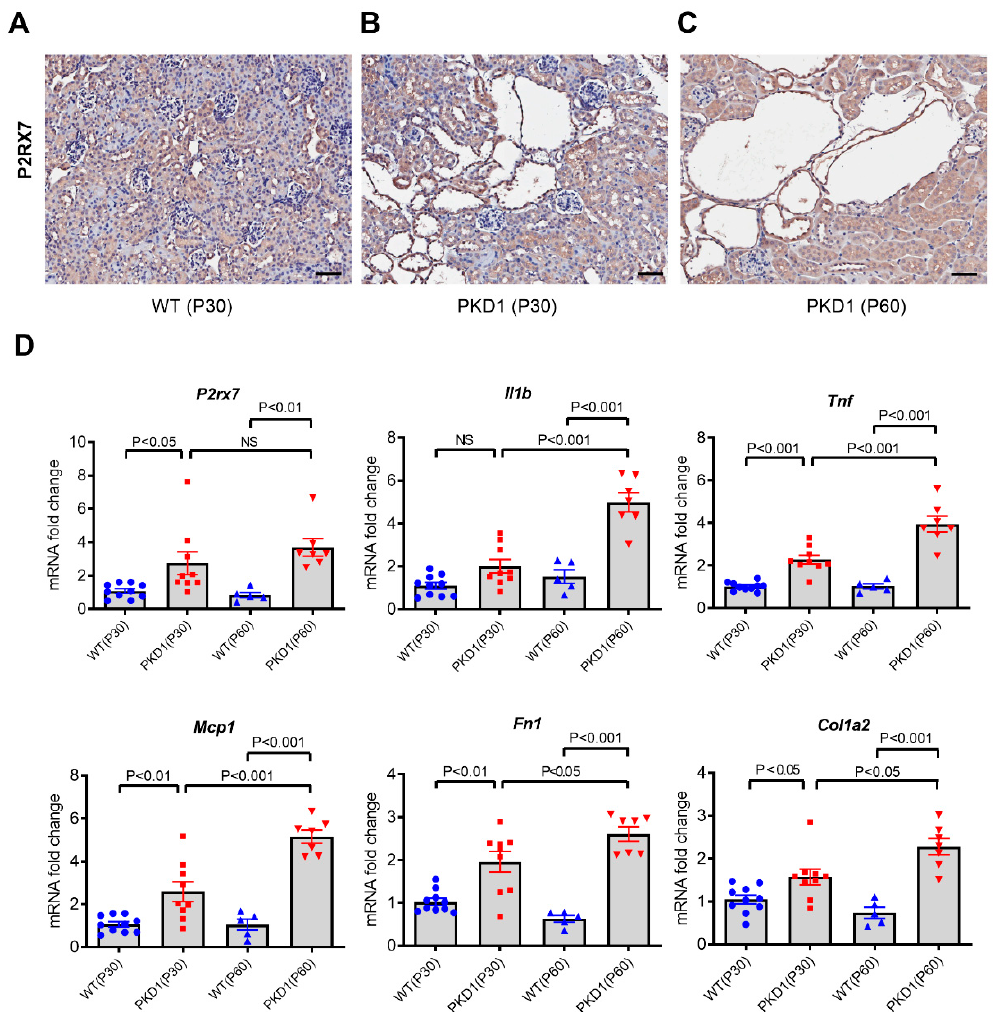
Figure 1. The expression of P2X7 receptors in wild-type and Pkd1- miR Tg mice. ( A ) Representative images of kidney sections showing diffuse immunostaining for P2X7 receptors in renal tubules in wild-type mice (n = 5). ( B ) Strong staining for P2X7 receptors is noted in the cyst-lining epithelial cells in the Pkd1 miR Tg mice at 30 days of postnatal age (n = 5). ( C ) Diffuse staining for P2X7 receptors in cyst walls and non-cystic tubules in the Pkd1 -miR Tg mice at 60 days of age (n = 5). ( D ) Comparison of the renal mRNA expression of P2rx7 and other pro-inflammatory and pro-fibrotic genes in the kidneys of wild-type and Pkd1 miR Tg mice according to different postnatal ages (n = 10, 9, 5, 7, respectively). Data are mean ± SEM. Scale bar, 50 µm.